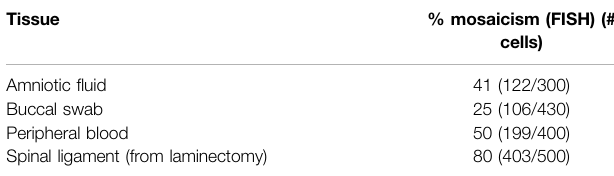
TABLE 1 | Degree of mosaicism of the sSMC in different tissues.